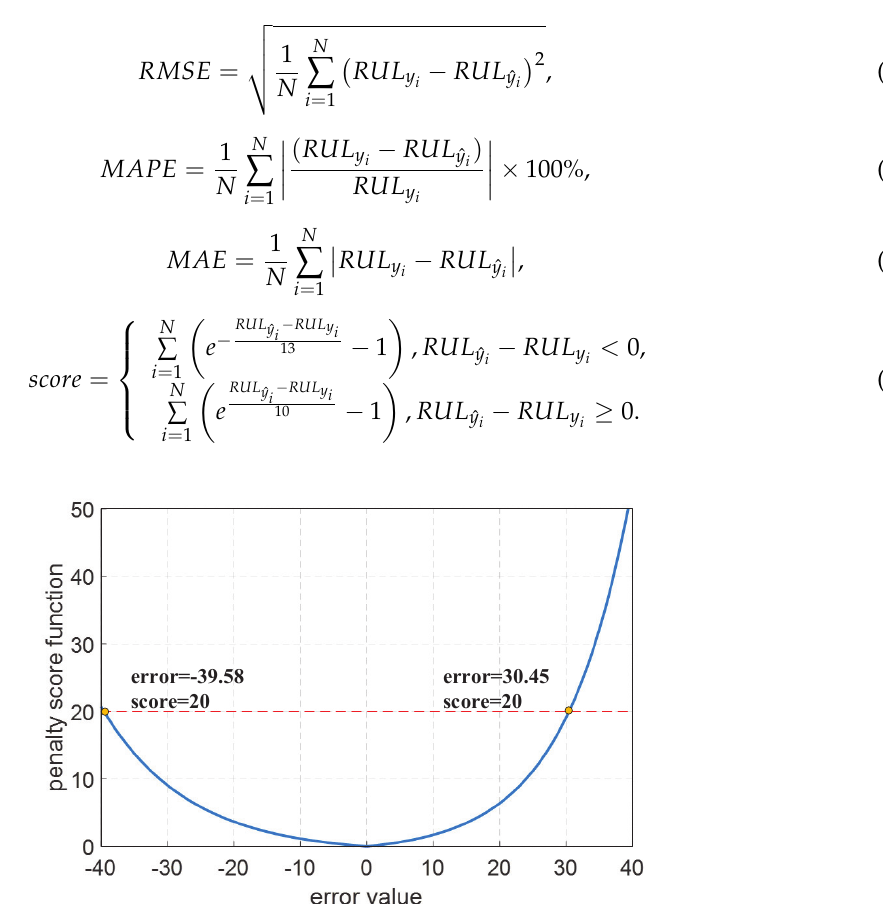
Figure 7. Penalty score